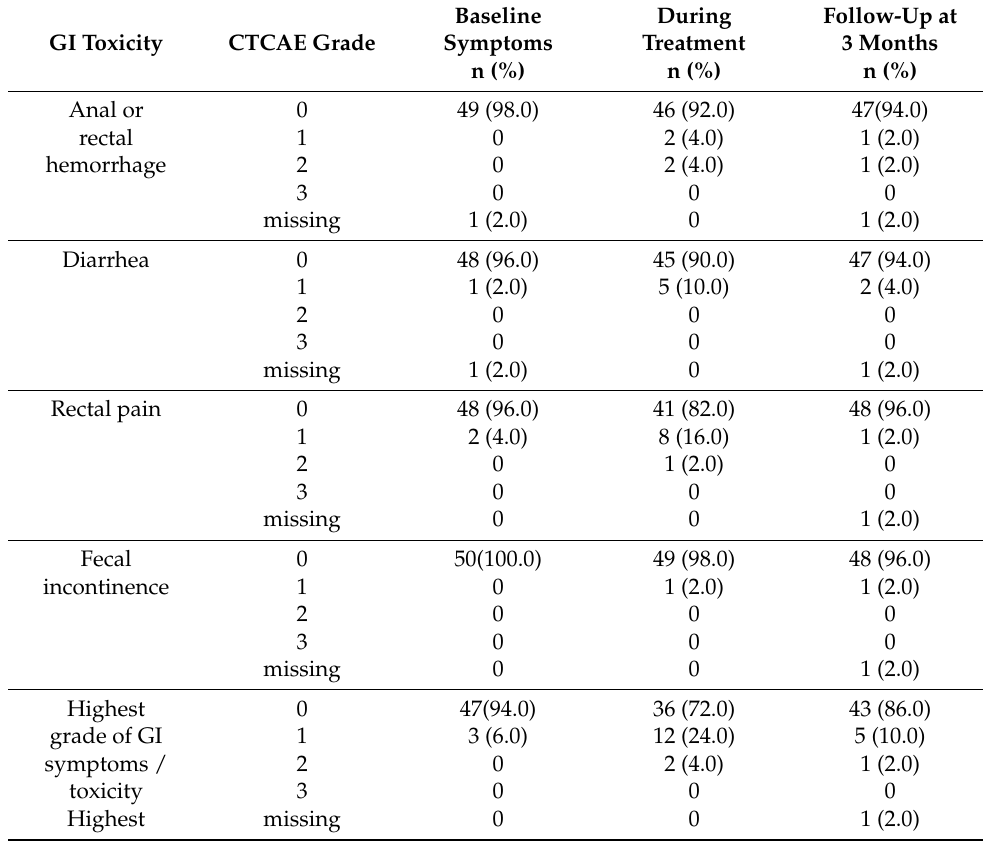
Table 3. Acute GI-Toxicity (GI: gastrointestinal; CTCAE: National Cancer Institute Common Termi- nology Criteria for Adverse Events version